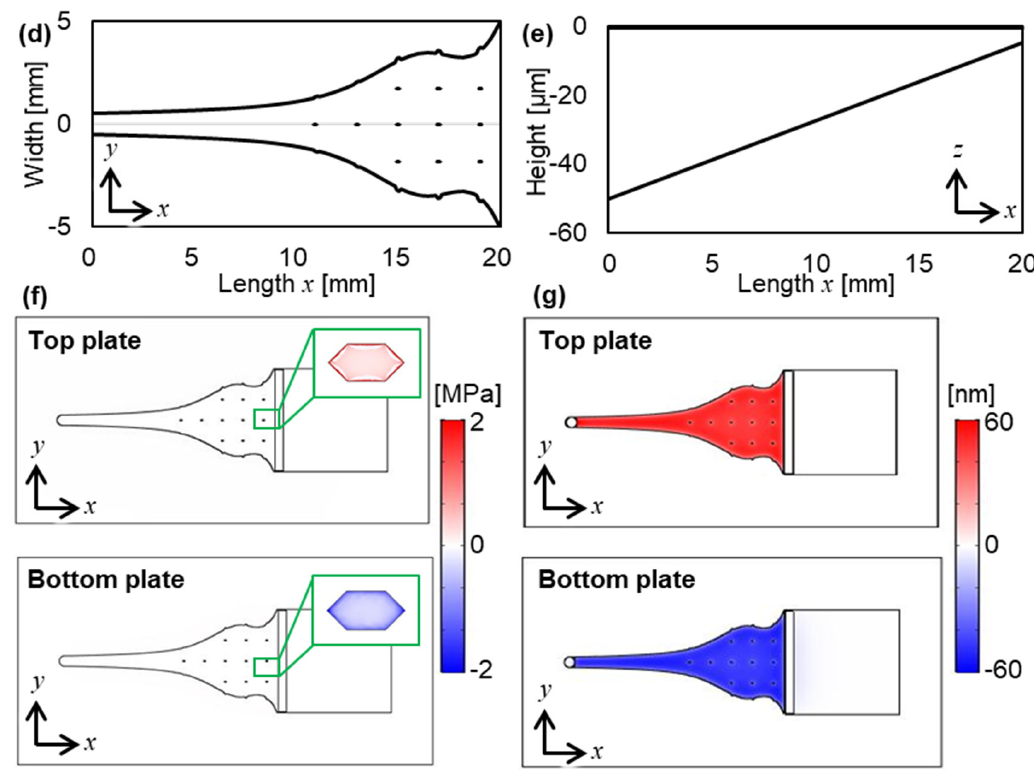
Figure 3. Design of the microchannel. ( a-1 ) Model configuration and ( a-2 ) Finite element method (FEM) image of the stress and ( b ) Analysis result of the relationship between the maximum stress and width of the microchannel. Considerations in the design of the microchannel. ( c ) Model configuration of the microfluidic bioreactor, ( d ) Width of the designed microchannel, ( e ) Height of the designed microchannel, ( f ) FEM image of the stress, and ( g ) FEM image of the deformation of the designed microfluidic bioreactor.